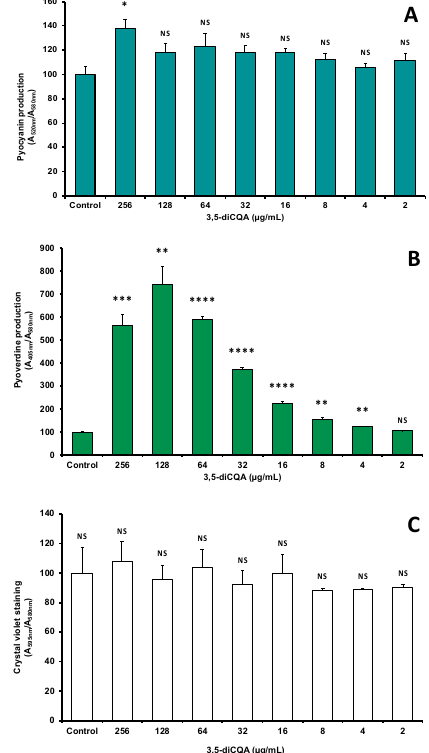
Figure 8. Effect of various concentrations of 3,5-dicaffeoylquinic acid (di-CQA). ( A ) On pyocyanin production by P. aeruginosa . ( B ) On pyoverdine production by P. aeruginosa . ( C ) On biofilm formation by P. aeruginosa . Statistics were achieved by a two-tailed t test using Prism GraphPad online tool (https://www.graphpad.com/quickcalcs/ttest1/). The mean with SEM were calculated and plotted. **** p < 0.0001; *** p = 0.0001 to 0.001; ** p = 0.001 to 0.01; * p = 0.01 to 0.05; NS (Not Significant), p ≥ 0.05.